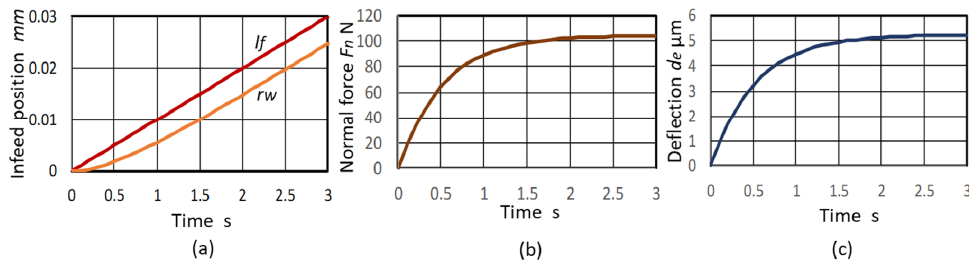
Figure 10. Responses to ramp infeed in cylindrical infeed grinding (plunge grinding). ( a ) Actual infeed; ( b ) Normal grinding force; ( c ) Machine deflection.